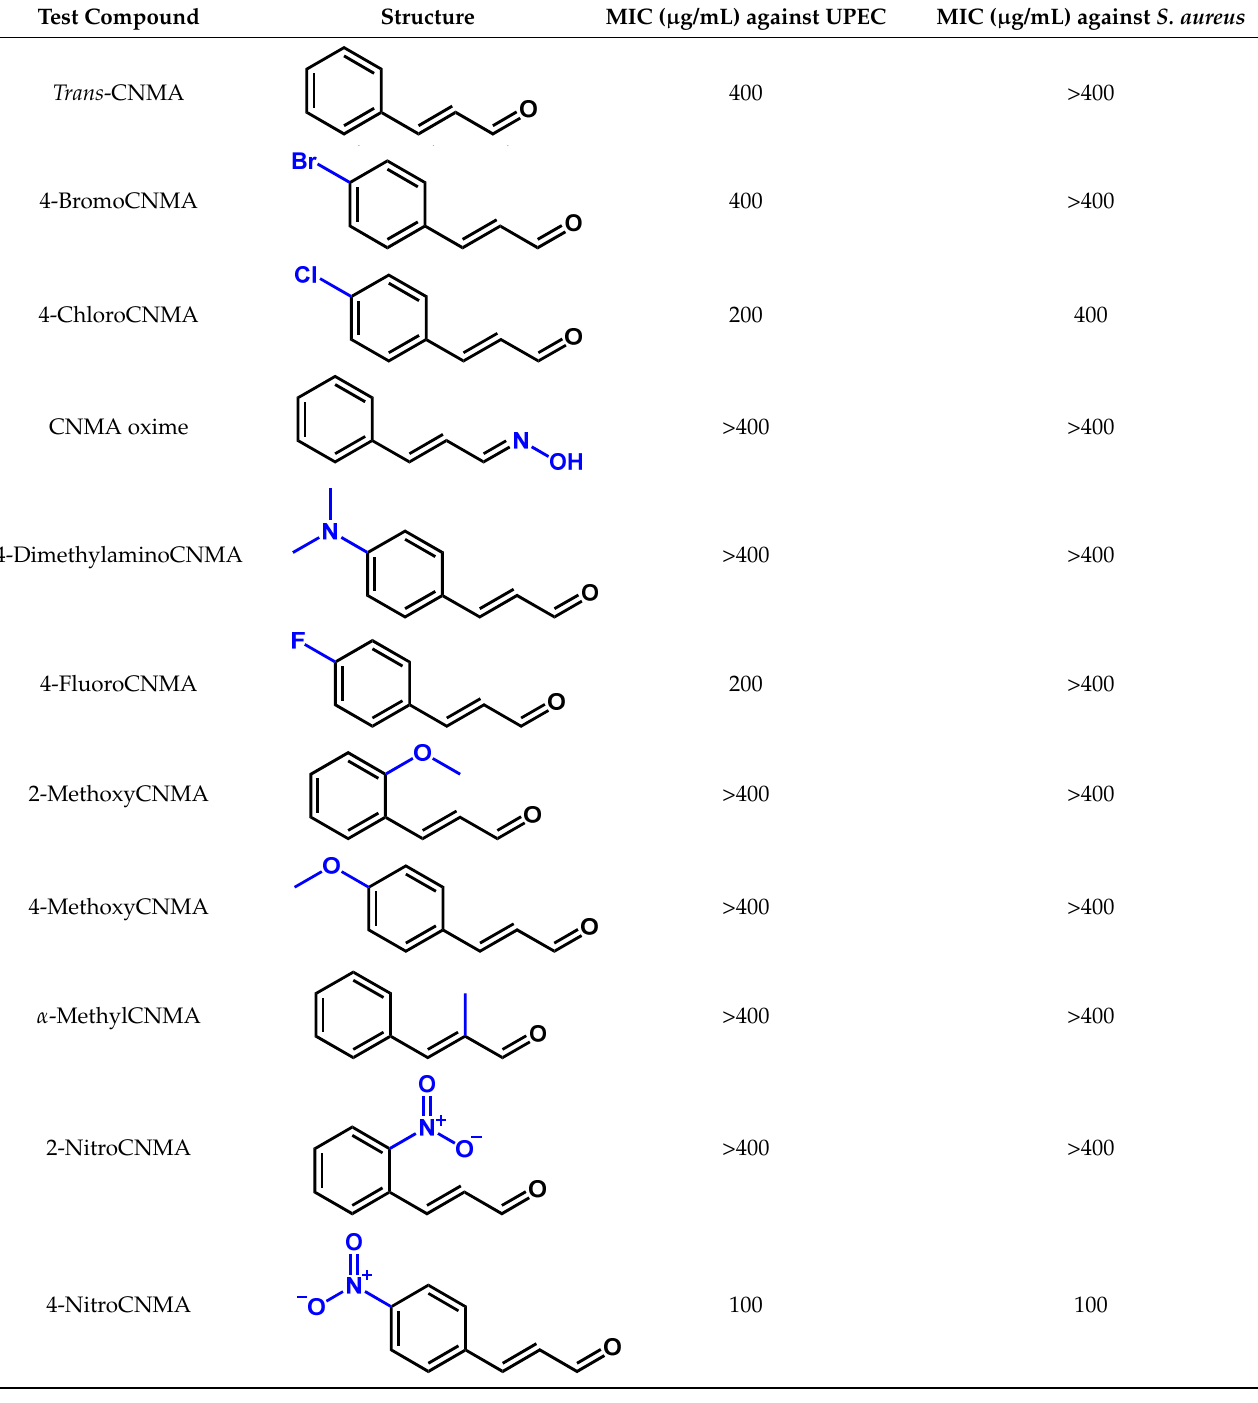
Table 1. The MICs of CNMAs against UPEC and S. aureus . Test Compound Structure